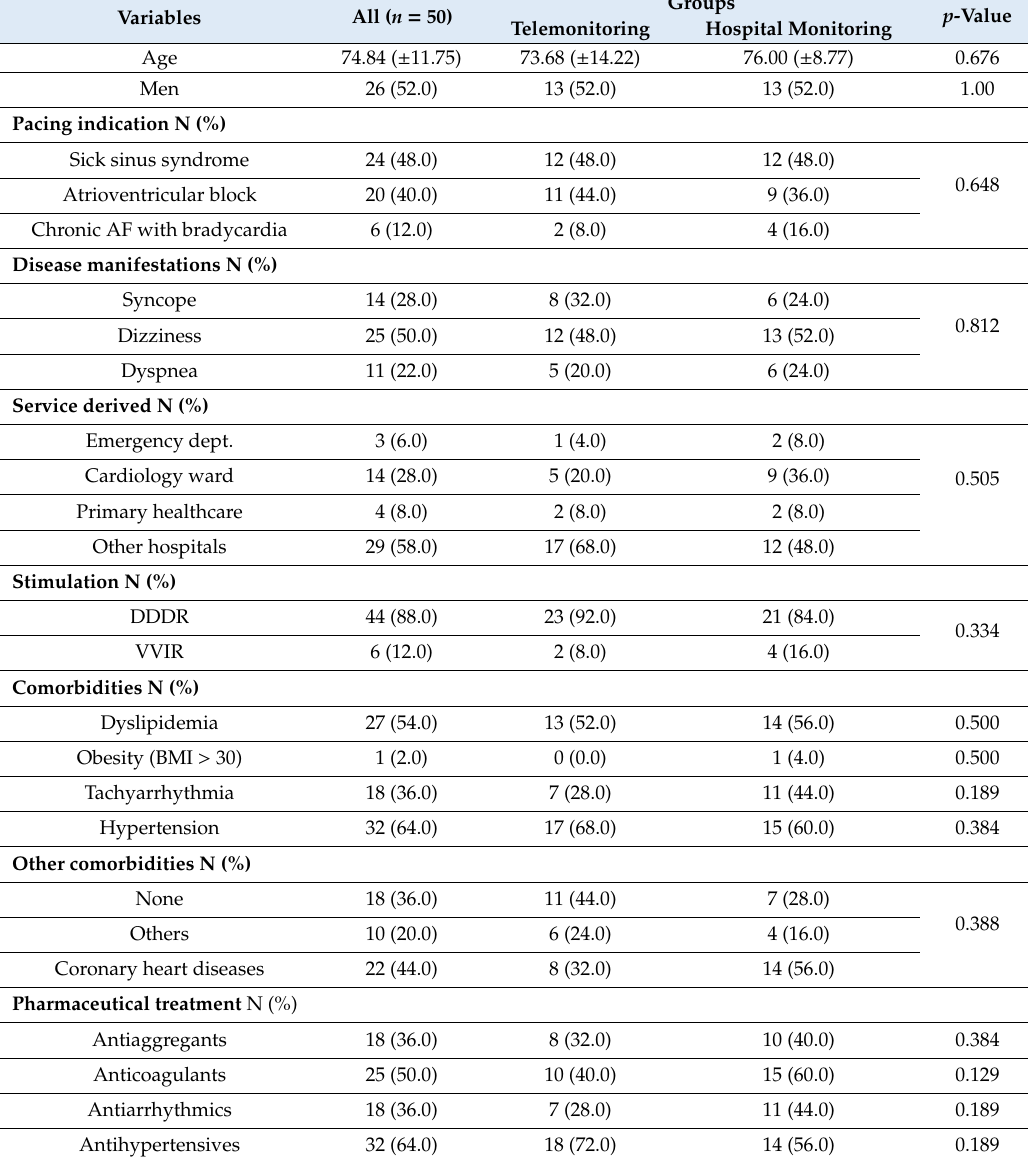
Table 3. Selected patient baseline characteristics by intervention